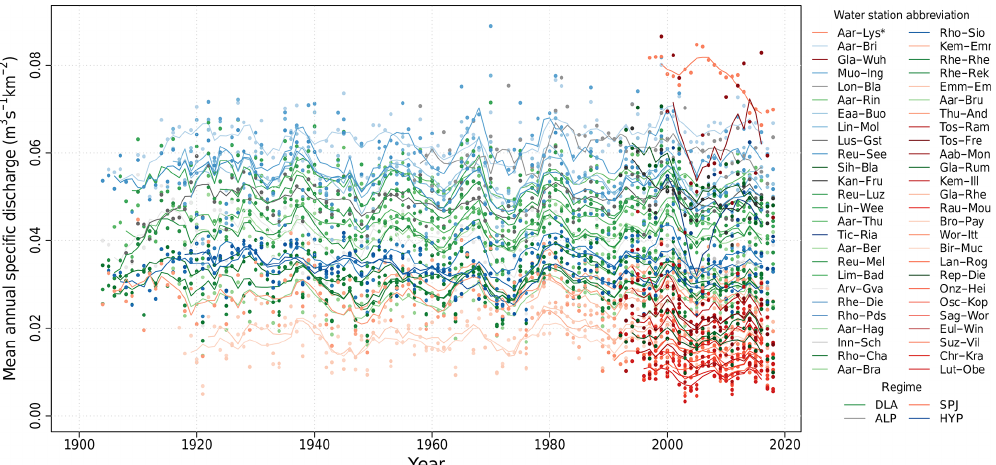
Figure 3. Mean annual specific discharge for the 52 catchments described in Table 1 (normalized by catchment area for comparison). Lines show the 5-year moving averages. Colours indicate the hydrological regimes. Values for the Alte-Aare (Alt-Lys, marked using an asterisk in the legend) are divided by 4 to fit in the